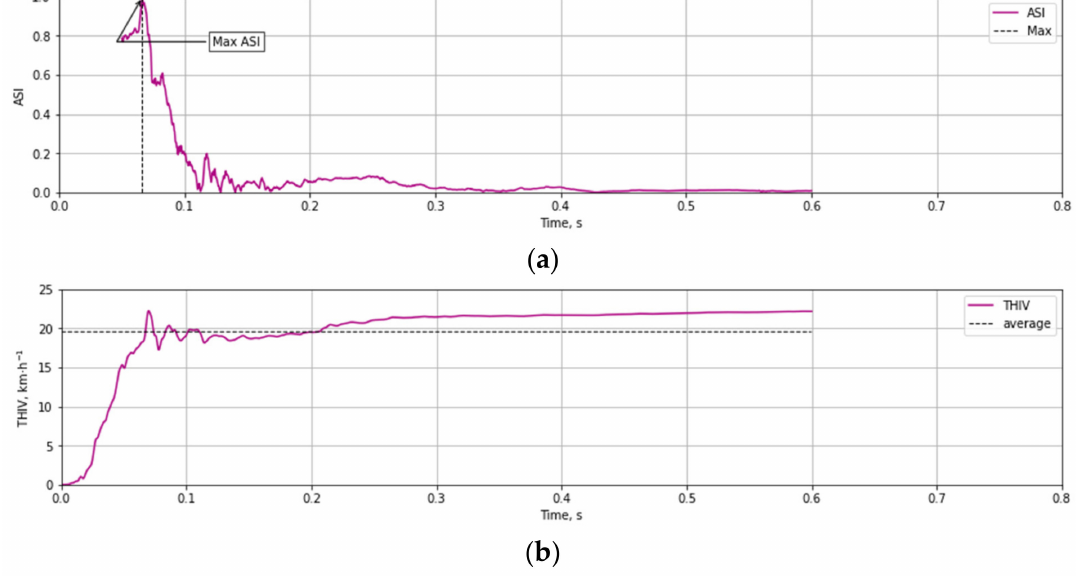
Figure 15. Experimental courses of the values of injury intensity parameters ( a ) ASI, ( b ) THIV as a result of an impact against T03 mast at 100